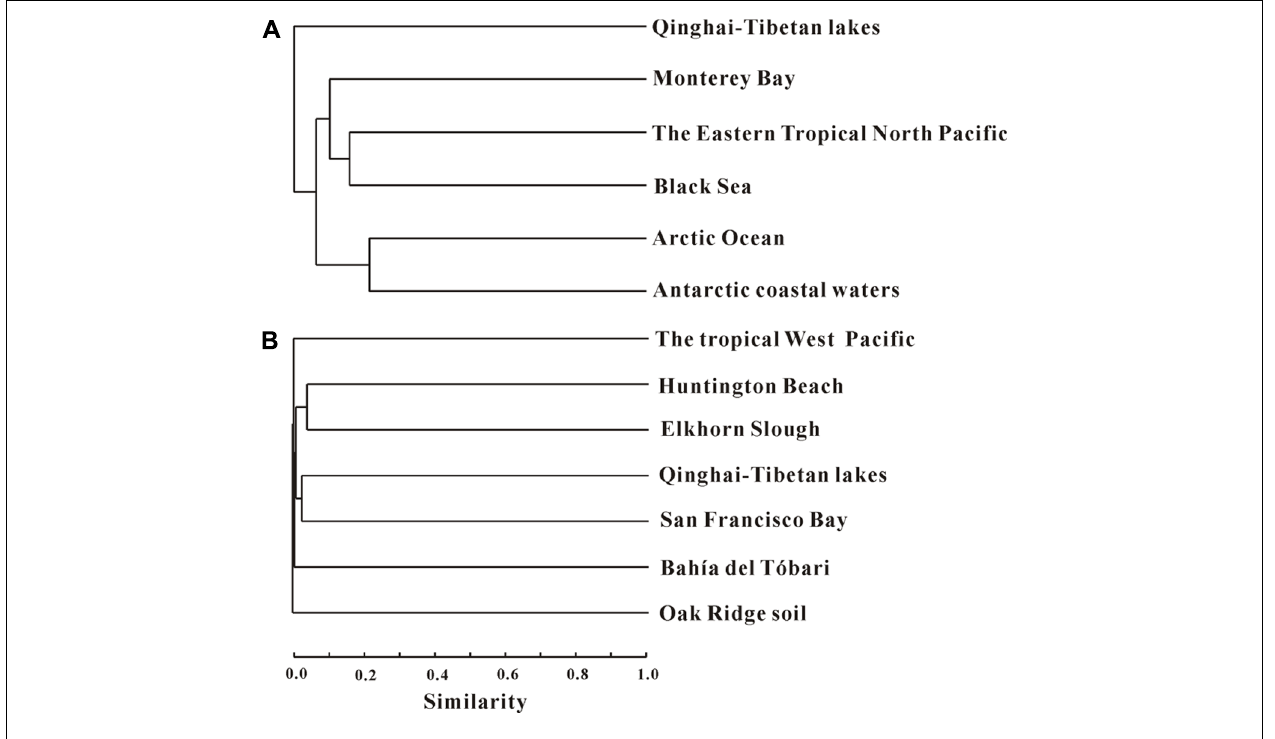
(Kalanetra etal., 2009). (B) The archaeal amoA gene sequences obtained in this study were compared with those previously reported in the sediments from Elkhorn Slough, and Huntington Beach of California, Bahía delTbóari of Mexico, and the San Francisco Bay (Francis etal., 2005), the tropicalWest Pacific Continental Margin (Dang etal., 2009), and an Oak Ridge soil (Francis etal., 2005).The numbers of clones from each location are given in Table 1